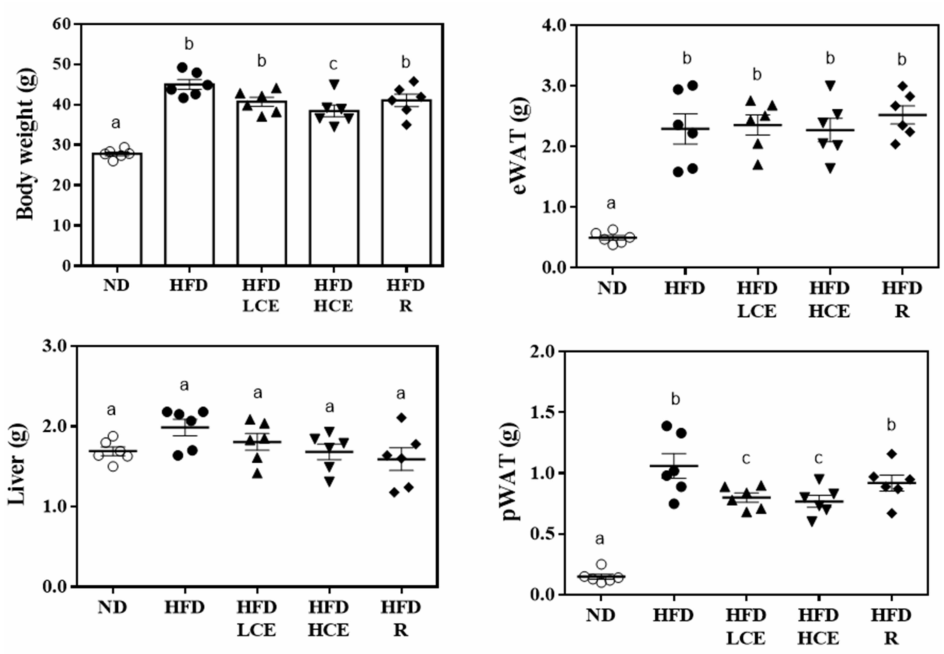
Figure 2. Effect of Djulis hull crude extract and rutin on body weight and tissue weight in HFD- induced obese mice. ND: normal diet; HFD: high-fat diet; LCE: low dosage of crude extract; HCE: high dosage of crude extract; R: rutin; eWAT: epididymal white adipose tissue; pWAT: perirenal white adipose tissue. Values represent the mean ± SEM (n = 6). Statistical methods were used by one-way ANOVA, and the different letters are significantly different at p <